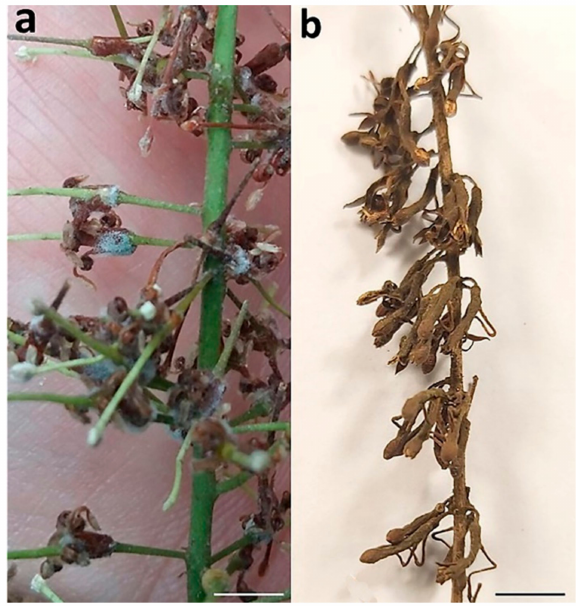
Figure 1. Macadamia racemes with symptoms of ( a ) grey mold, and ( b ) green mold. Scale bars: ( a ) = 5 mm; ( b ) = 10